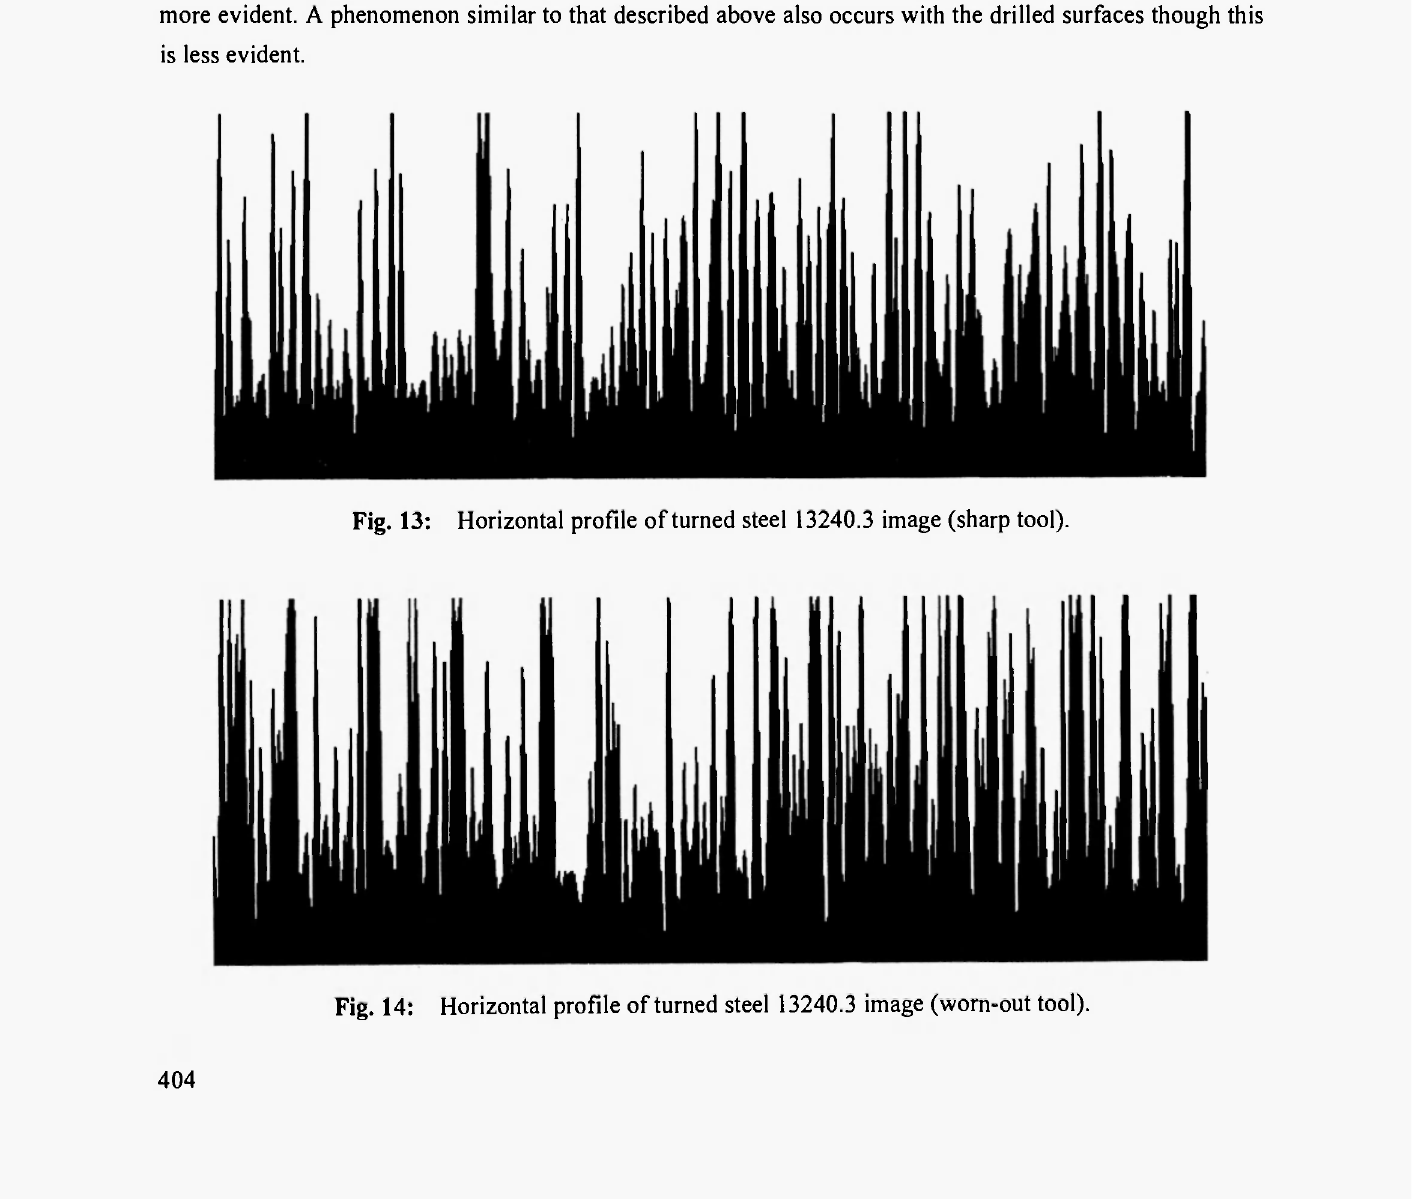
Fig. 14: Horizontal profile of turned steel 13240.3 image (worn-out